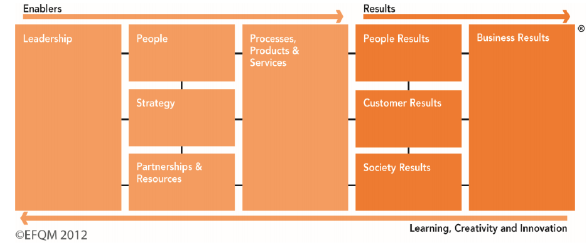
Figure 1: The 9 criteria of the EFQM 2013 Model